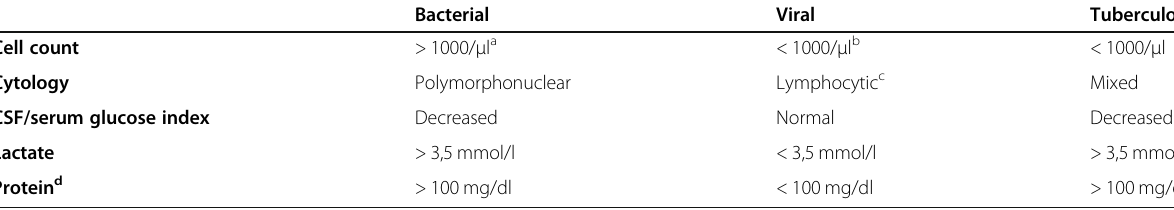
Table 1 Typical CSF parameters in meningitis (according to [3])